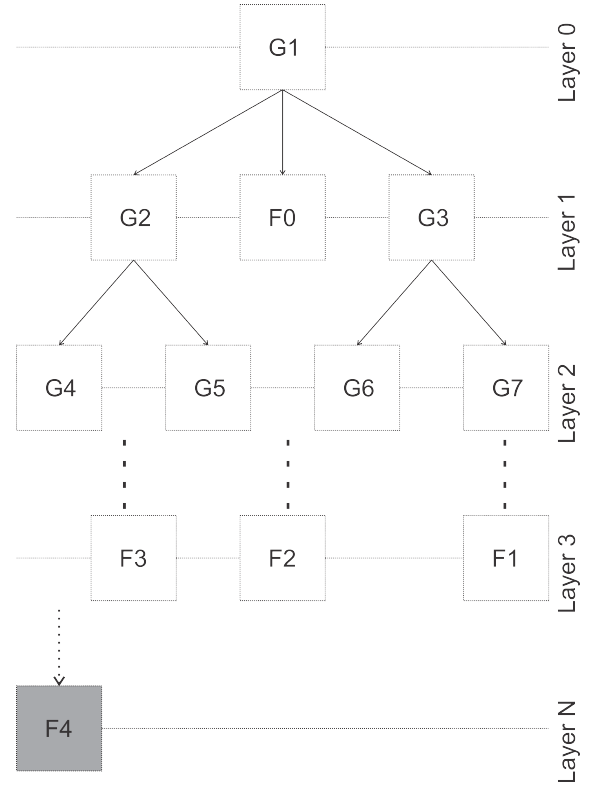
Figure 4. Logical representation of fault signature